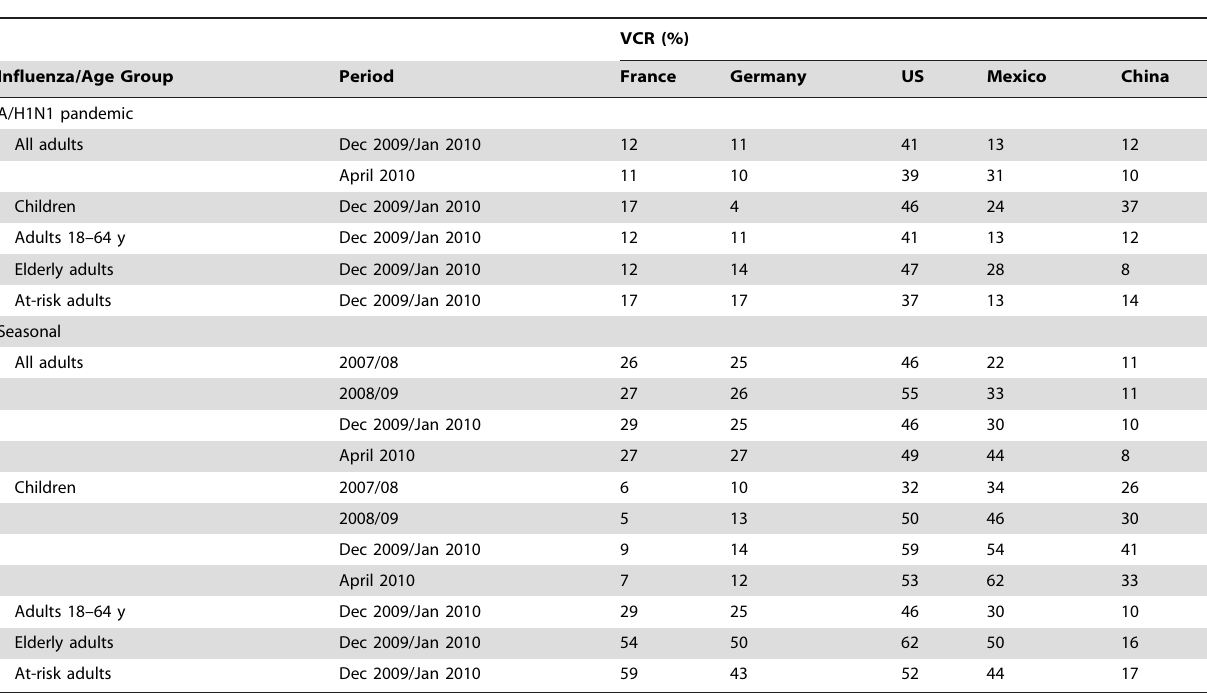
Table 1. VCRs for A/H1N1 pandemic and seasonal